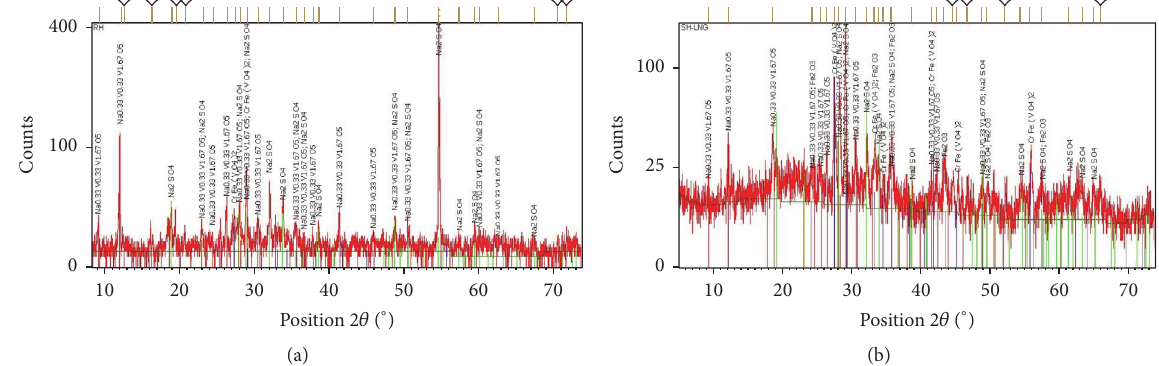
Figure 8: XRD patterns of corrosion products and deposits on the surface of (a) reheater and (b) superheater tubes.